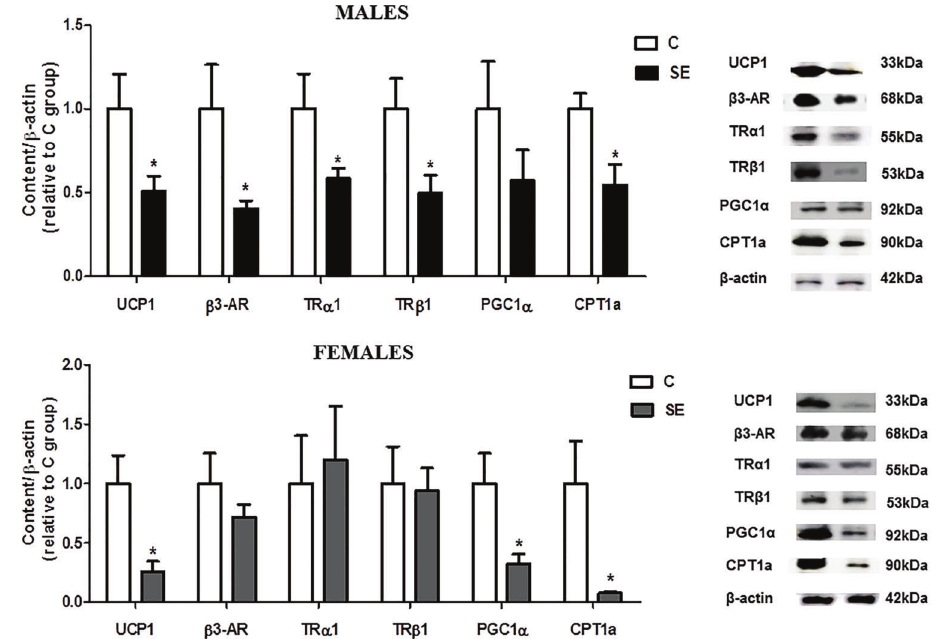
Figure 4. Long-term effects of neonatal cigarette smoke exposure on brown adipose tissue (BAT) functional parameters in male and female offspring. UCP1, b 3-AR, TR a 1, TR b 1, PGC1 a , and CPT1a protein contents in BATat 180 postnatal days. Representative blots of the proteins are shown beside the graphs. b -Actin content was used as control loading. C: control group; SE: smoke-exposed group. Data are reported as means ± SE for n=7 – 8. *P o 0.05 ( t -test).